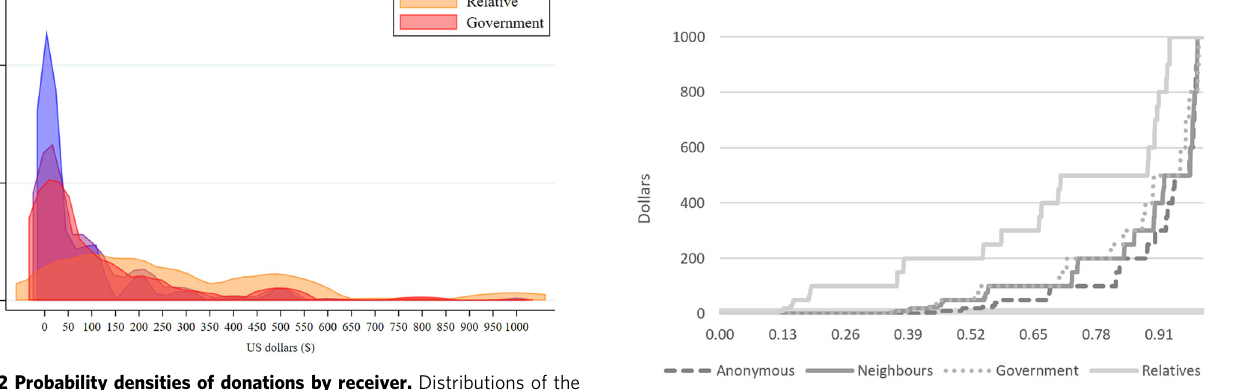
Fig. 3 Cumulative donations by receiver. Cumulative distribution of donations in the sample of each of the four dictator game